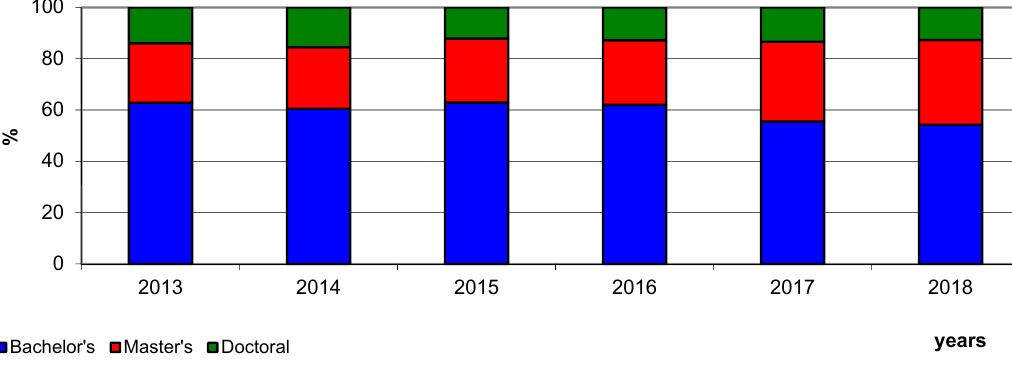
Table 2. Dynamics indicators for the number of students studying electricity and energy in EU countries in 2013–2018 (year 2013 = 100).